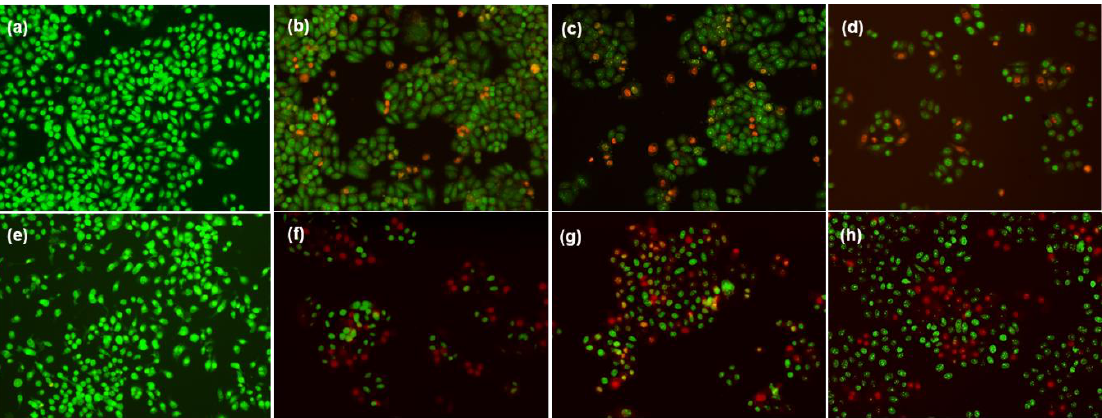
Figure 10. Fluorescence microscopic images of RAW macrophage cells control, A549 lung cancer cells control ( a , e ) and the cells exposed with AgNPs ( b , f ), TiO 2 /AgNCs ( c , g ) and ZnO/TiO 2 /AgNCs ( d , h ). Green fluorescence indicates viable cells; orange and red fluorescent colours indicate late apoptotic and dead cells.